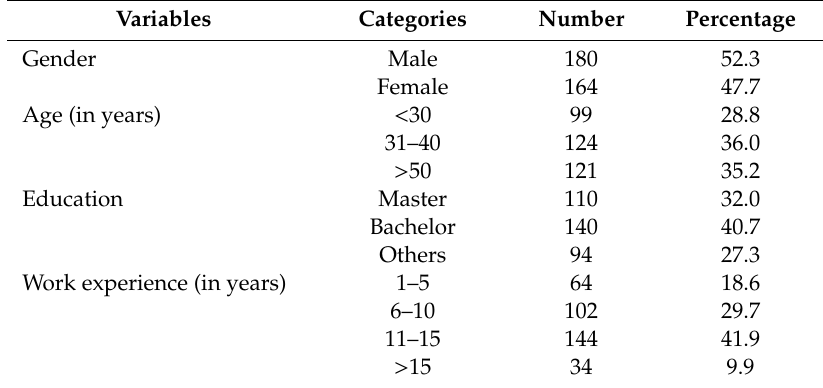
Table 1. Respondents’